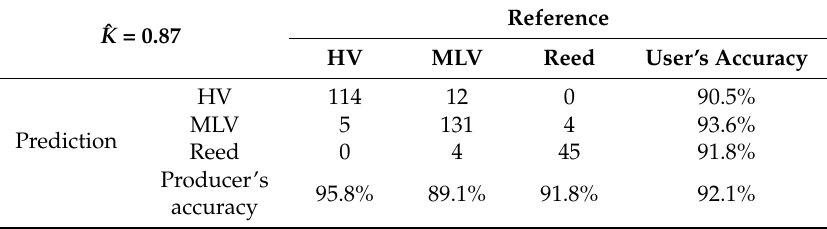
Table 9. Confusion matrix of the RF model using all of the bands, excluding Red Edge band (RF model 6). ˆ K =